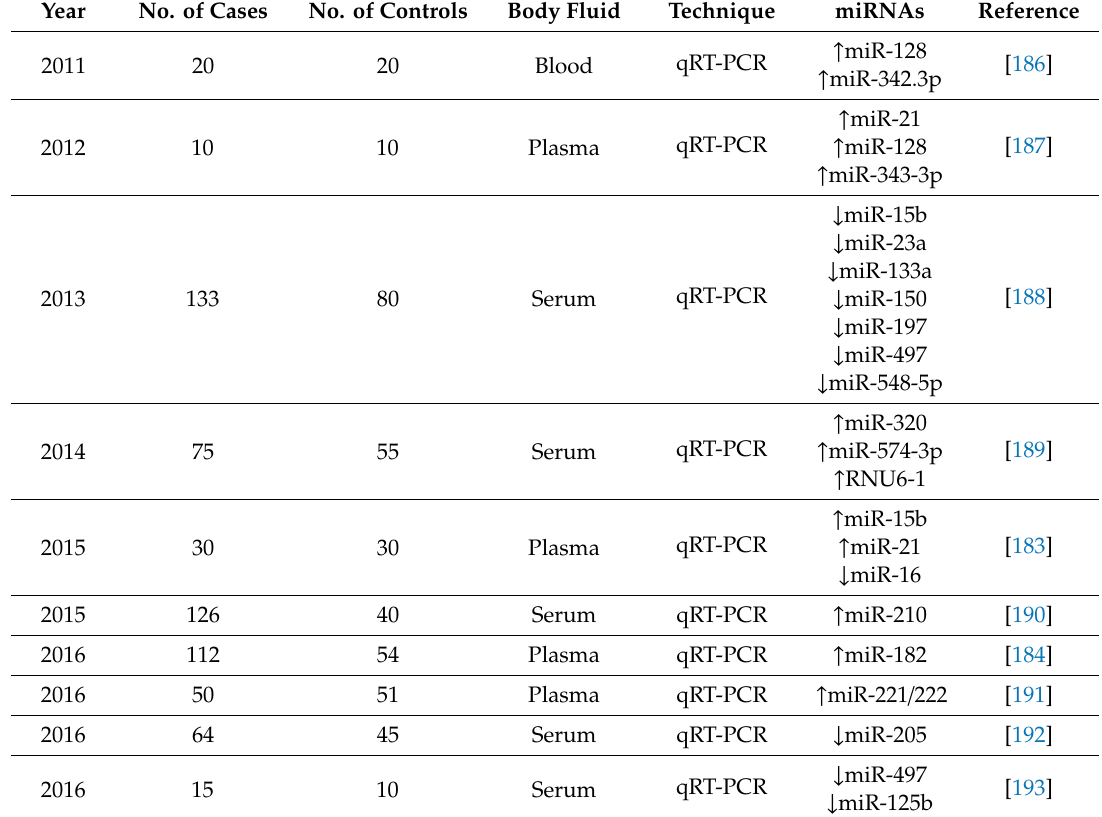
Table 2. Deregulated miRNAs in body fluids. CSF: cerebrospinal fluid. ( ↑ increased; ↓